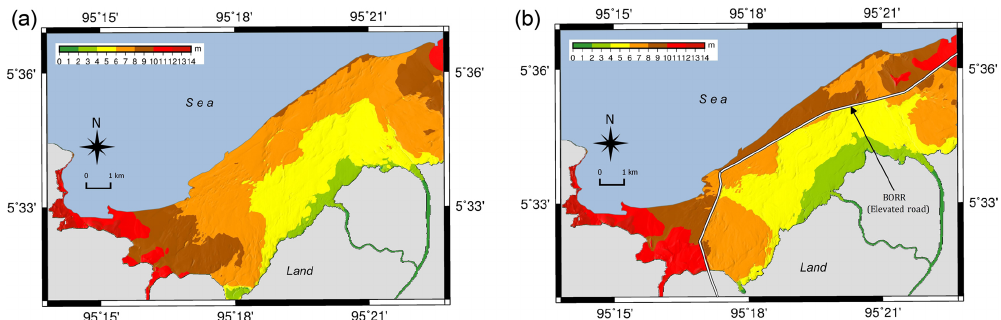
Figure 11. Maximum tsunami wave depths based on the 9.15 M w earthquake without BORR (a) and with BORR (b) . The simulations are based on the 2029 land use planning of Banda Aceh. Table 6. Maximum velocities after the elevated road